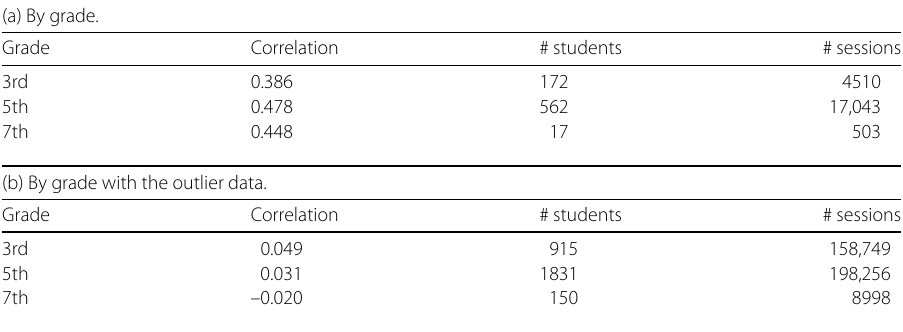
Table 5 Correlation between reading ability test data and app generated reading speed (a) By grade.